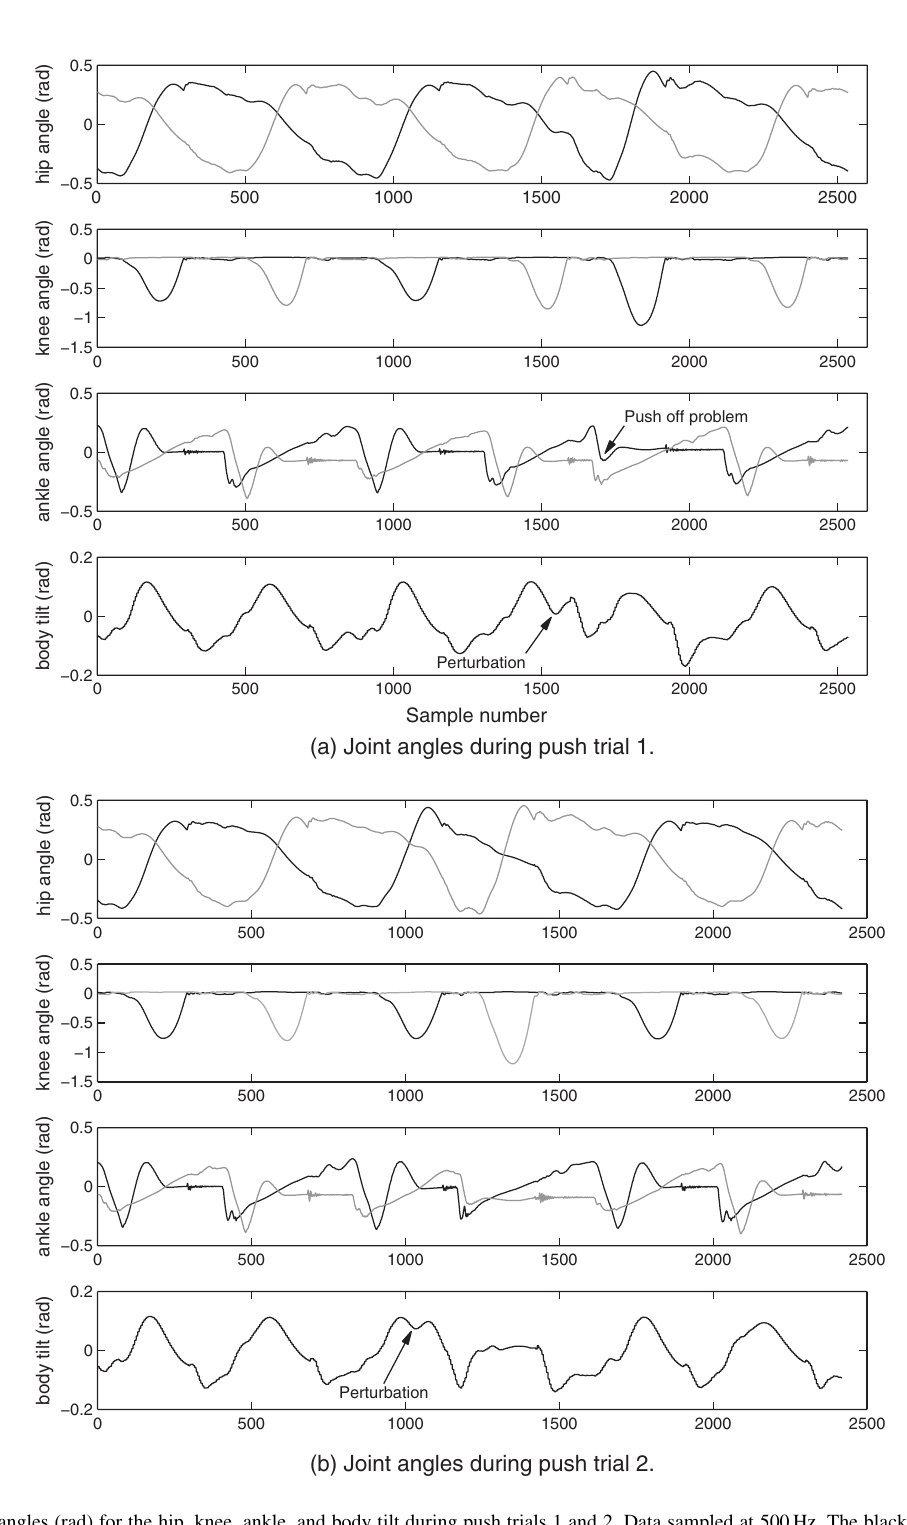
Fig. 9. Joint angles (rad) for the hip, knee, ankle, and body tilt during push trials 1 and 2. Data sampled at 500Hz. The black and grey lines represent the inner and outer legs respectively. The moment at which the perturbation is applied is indicated by an arrow in the body tilt